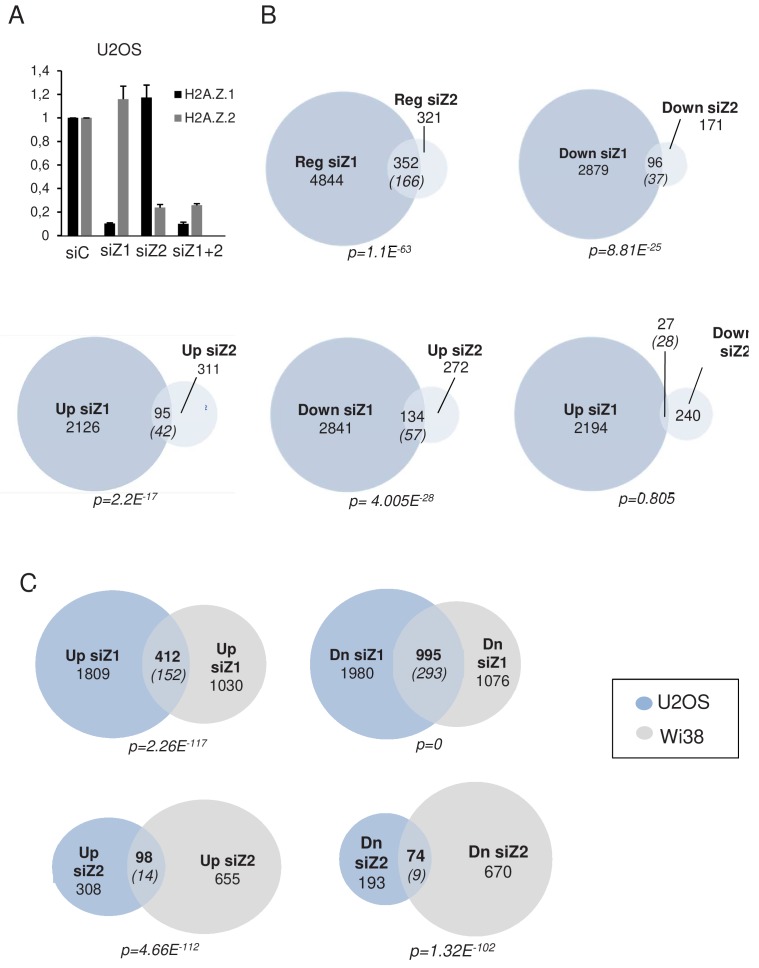
RNA-seq analysis after H2A.Z.1 and H2A.Z.2 depletion in U2OS cells.(A) U2OS cells were transfected with the indicated siRNAs. 72 hr later, total RNA was prepared. The amount of H2A.Z.1 and H2A.Z.2 mRNA was quantified by RT-qPCR, standardised using GAPDH mRNA levels and calculated relative to one for cells transfected with the control siRNA. The mean and SDOM from three independent experiments are shown. (B) H2A.Z.1 and H2A.Z.2 regulate specific and common genes in U2OS cells. RNA Seq data from U2OS cells were analysed for differential gene expression in samples transfected by either the H2A.Z.1 siRNA or the H2A.Z.2 siRNA versus the control siRNA sample. Venn diagram showing the intersection between the genes differentially expressed upon H2A.Z.1 and H2A.Z.2 inhibition, between genes up-regulated in the two samples, down-regulated in the two samples or regulated in an opposite way in the two samples. Note that, as for WI38, the intersection between genes upregulated upon H2A.Z.1 depletion and down-regulated upon H2A.Z.2 depletion is not highly significant. The numbers in brackets indicate the expected number of genes considering the total number of expressed genes if intersection was random. The p-value was calculated using the Chi-square test considering all expressed genes. (C) H2A.Z.1 and H2A.Z.2 regulate different genes in WI38 and U2OS cells. Venn diagram showing the intersection between lists of differentially expressed genes from RNA Seq data from WI38 and U2OS cells. Note that despite significant overlap, gene lists were mostly different. The numbers in brackets indicate the expected number of genes considering the total number of expressed genes if intersection was random. The p-value was calculated using the Chi-square test considering all expressed genes.Figure 2—figure supplement 3—source data 1.Source data of the histogramme representing the depletion of H2A.Z.1 and H2A.Z.2 in response to siRNAs in U2OS cells in Figure 2—figure supplement 3.